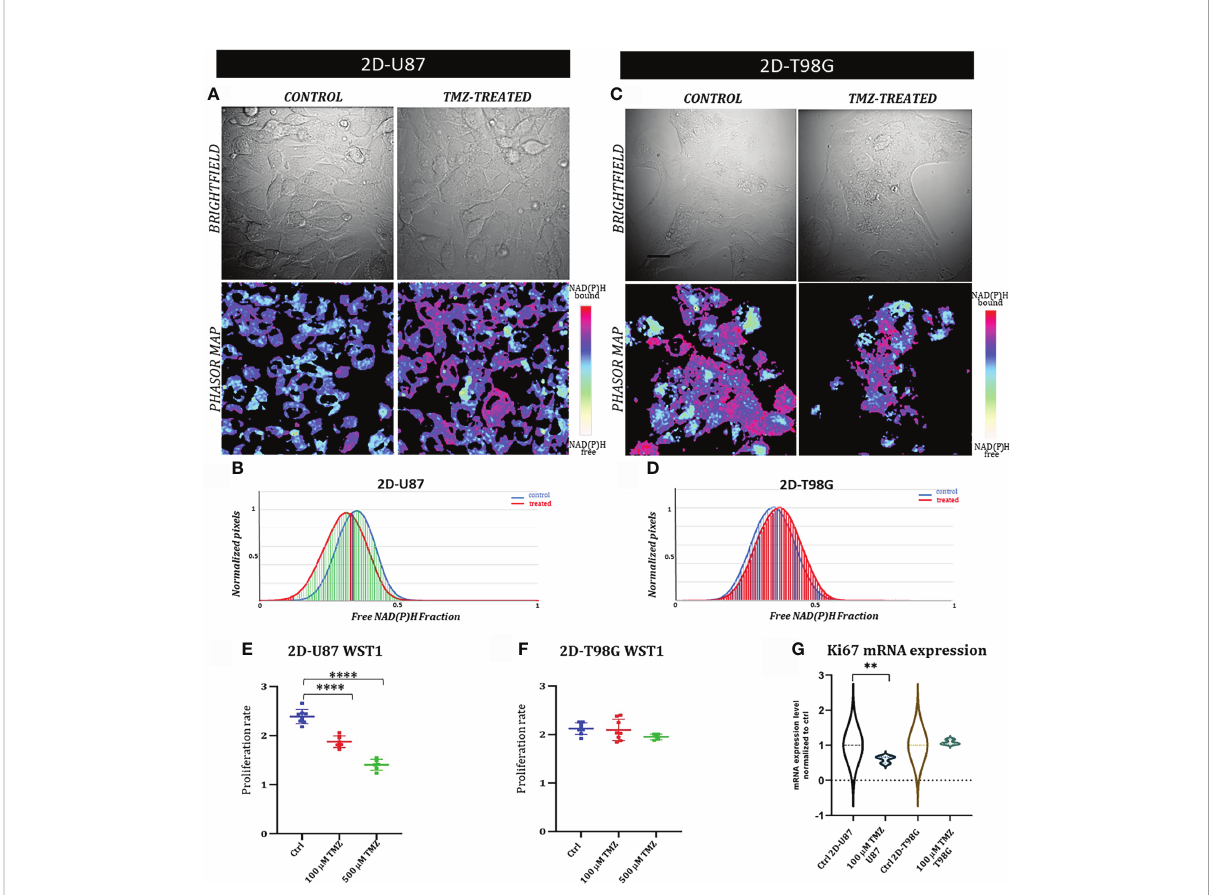
FIGURE 2 2D glioblastoma cell lines system: FLIM-based metabolic imaging in GB commercial cell lines TMZ responder 2D-U87 and TMZ non responder 2D- T98G. (A, C) Representative images of 2D-U87 (A) and 2D-T98G (C) subdivided in bright fi eld images and the corresponding phasor maps. Scale bar, 30 m m. (B, D) NAD (P) H fractional mean distribution curves of control (blue) and treated cells (red) for 2D-U87 (B) and 2D-T98G cells (D) , 72 hrs post TMZ treatment. (E, F) Proliferation curves of 2D-U87 (E) and 2D-T98G cell lines (F) after 72 hrs (p<0.001, Student ’ s t test). (G) Ki67 mRNA expression using real-time PCR in control and treated cells, 72hrs after treatment (p=0,002, Student ’ s t-test). Asterisks indicate level of statistical signi fi